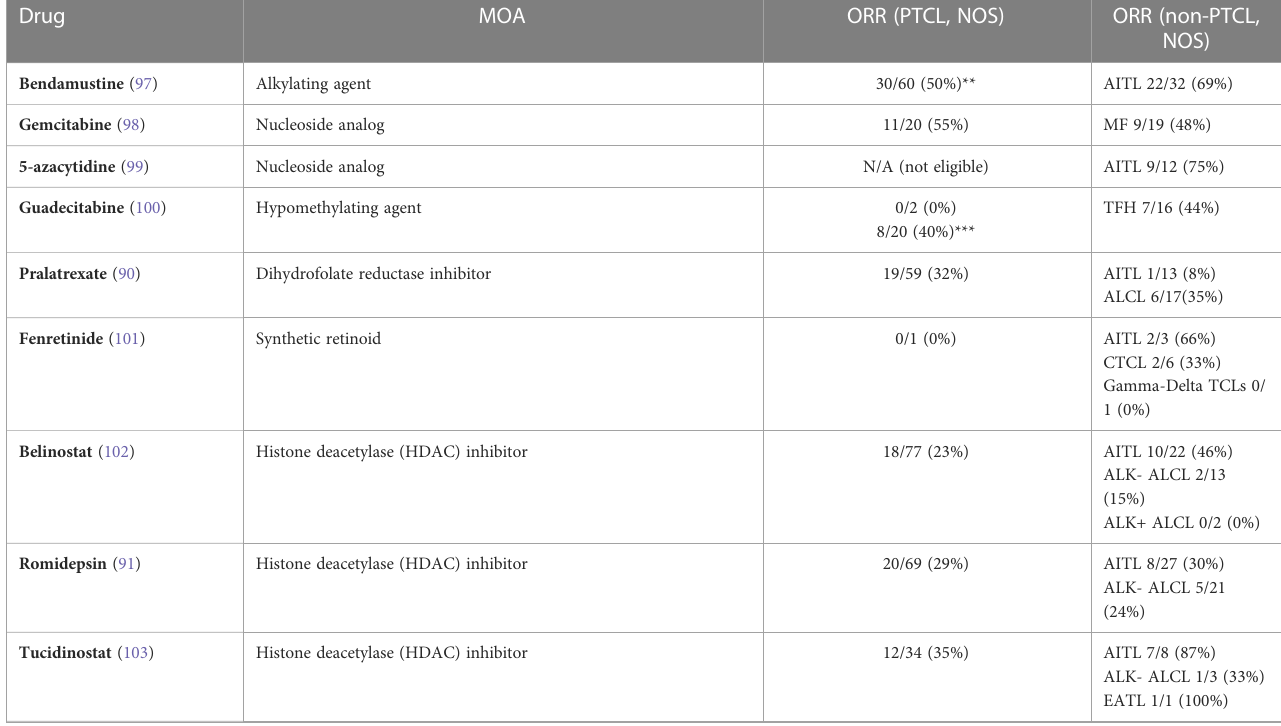
TABLE 1 Novel agents utilized in PTCL,